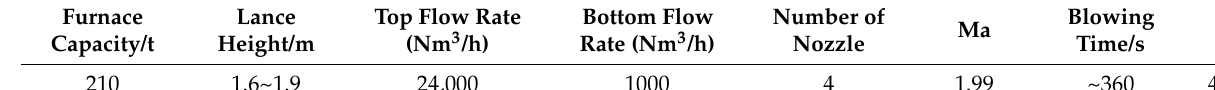
Table 2. Parameters during vanadium extraction smelting.